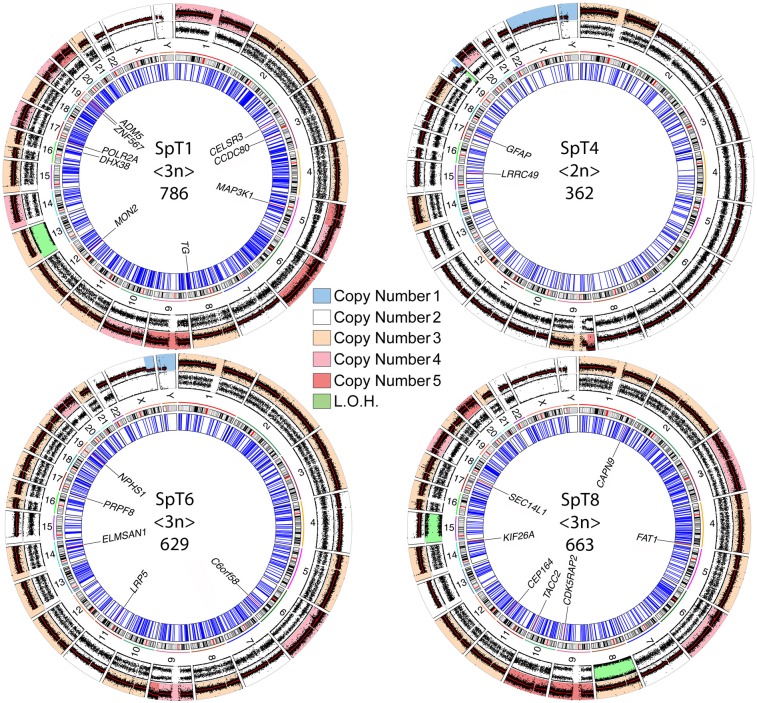
Circos plots of the four SpT tumors with matched normal tissue showing somatically acquired events.From outside inwards, the first ring represents chromosomal copy number (inferred from relative sequencing depth); color indicates chromosomal copy number as illustrated in key; the second ring shows the relative allele frequency of the minor (B-allele) allele for one million common SNPs (green color indicates LOH (loss of heterozygosity)); the third ring indicates chromosome number adjacent to a representative ideogram of the chromosome, with centromeric region highlighted in red. In the inner ring, radial blue lines correspond to all called acquired SNVs and indels, with validated coding non-synonymous mutations shown as radial red bars and labelled by their respective gene name. The tumor name, ploidy number (also see Table 1 and S2 Table) and total number of SNVs and indels (S3 Table) are presented in the center of each plot. Details of the location of the coding variants are given in S3A Table.